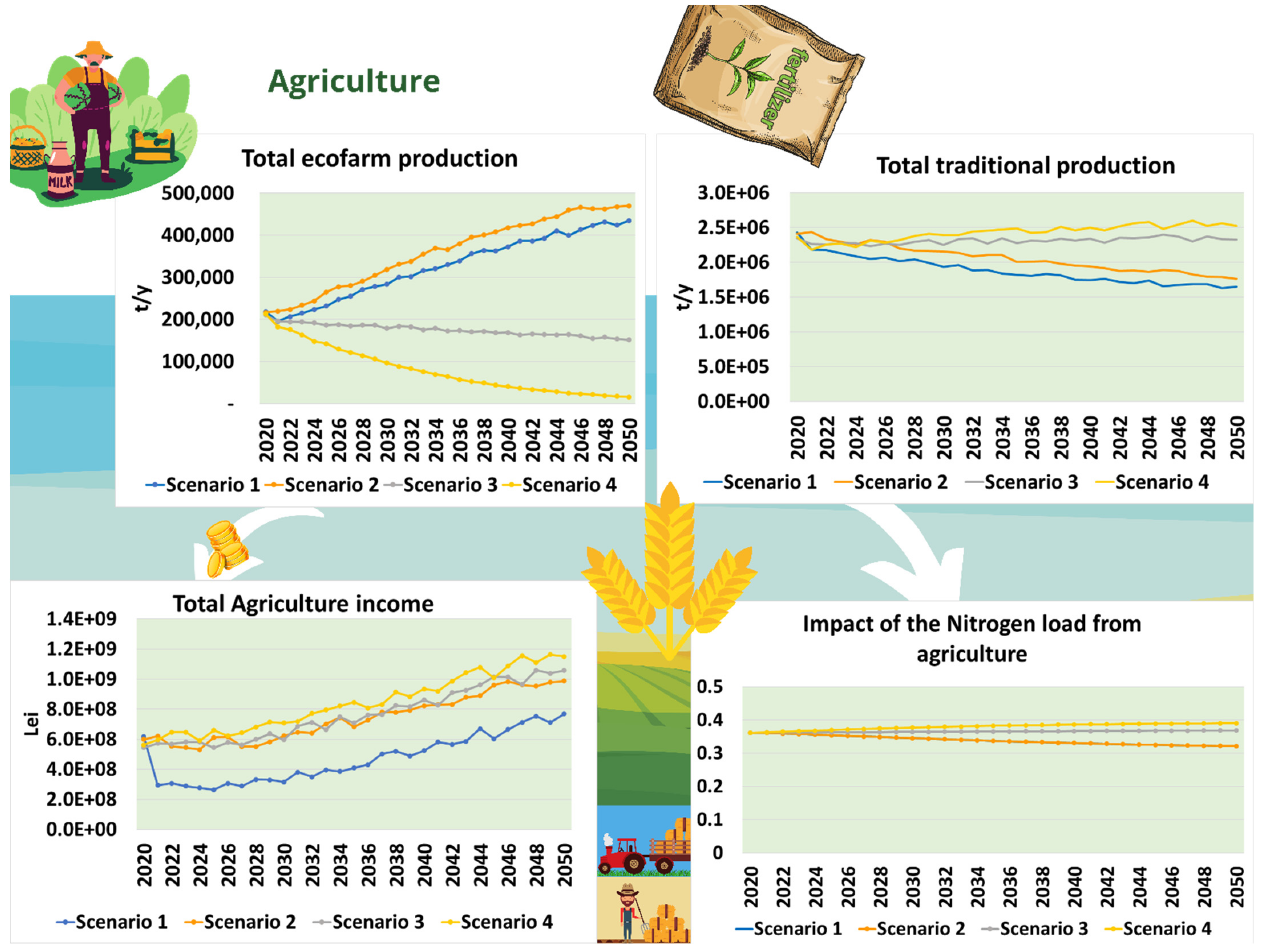
Figure 5. Agriculture’s KPI change in different scenarios—Danube Delta.